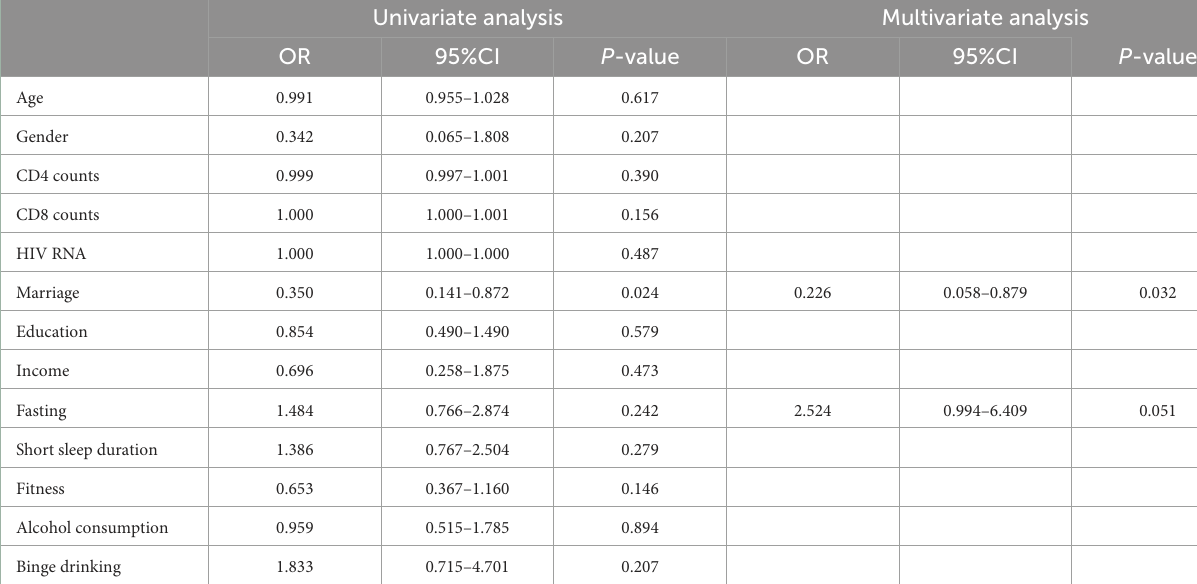
TABLE 2 Factors associated with of loneliness among people living with